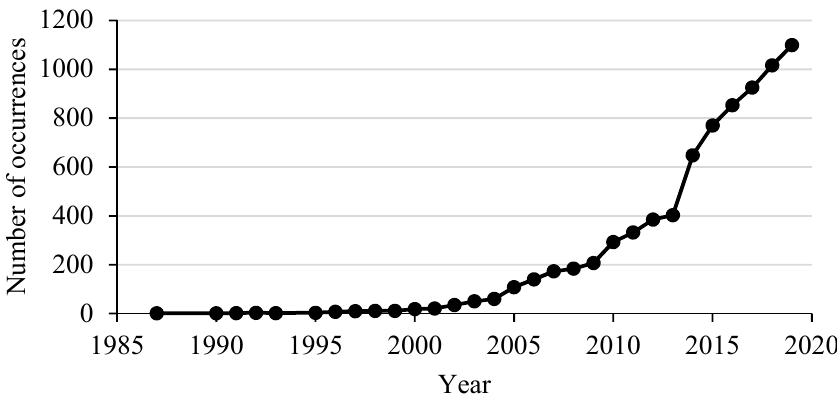
Figure 1. Number of occurrences of “biosecurity” in PubMed.gov.